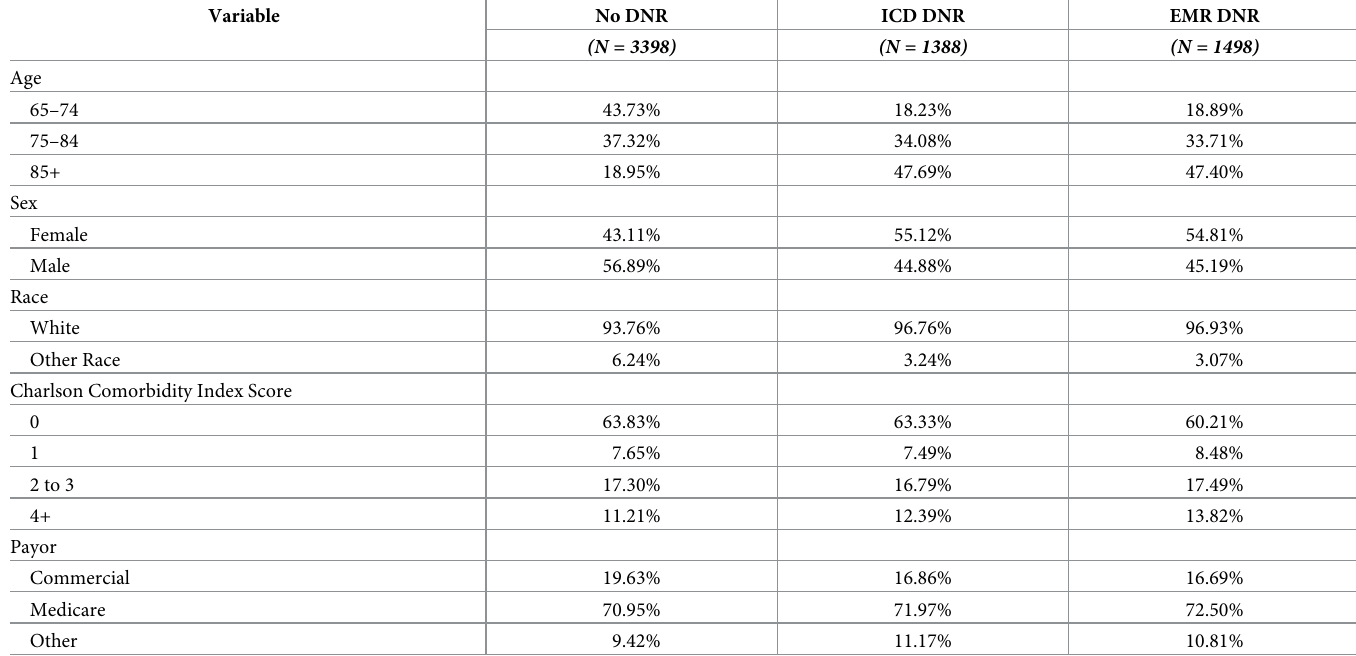
Table 1. Summary statistics for elderly HF patients, stratified by DNR status in ICD codes and